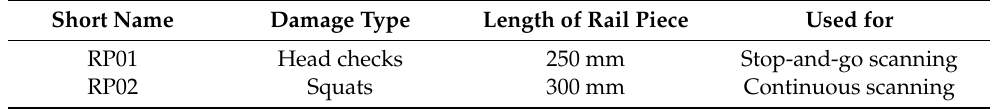
Table 1. Description of the two rail pieces.